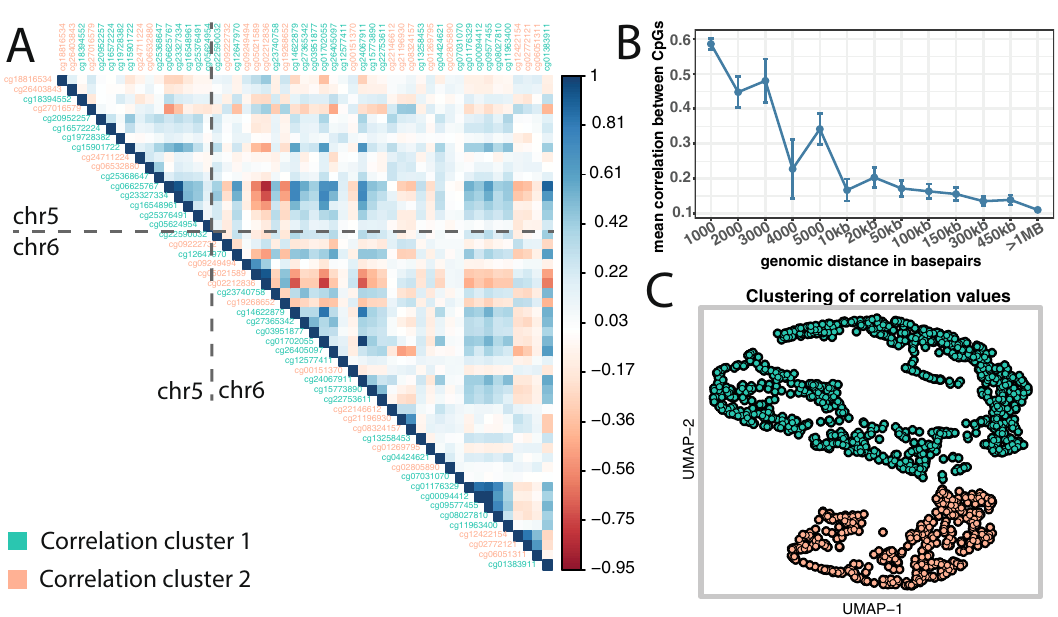
Fig. 2 Correlation structure of CRP-associated CpG methylation. Panel A gives meta-analyzed correlation values (Pearson Rho) across 4 cohorts. Displayed are all CRP-associated CpGs from a genomic region from chromosome 5 alongside with CRP-associated CpGs on chromosome 6. CpG ids are color-coded according to correlation clusters. Panel B CpGs correlation depending on distance. Correlation values were binned according to their distance to each other. X -axis gives distance between CpGs. Y -axis gives Pearson Rho observed each distance bin. In blue font, we plotted mean and standard errors of Person Rho values. Panel C is a UMAP representation of correlation values of the 1511 independent loci. Dots are color-coded according to their correlation cluster